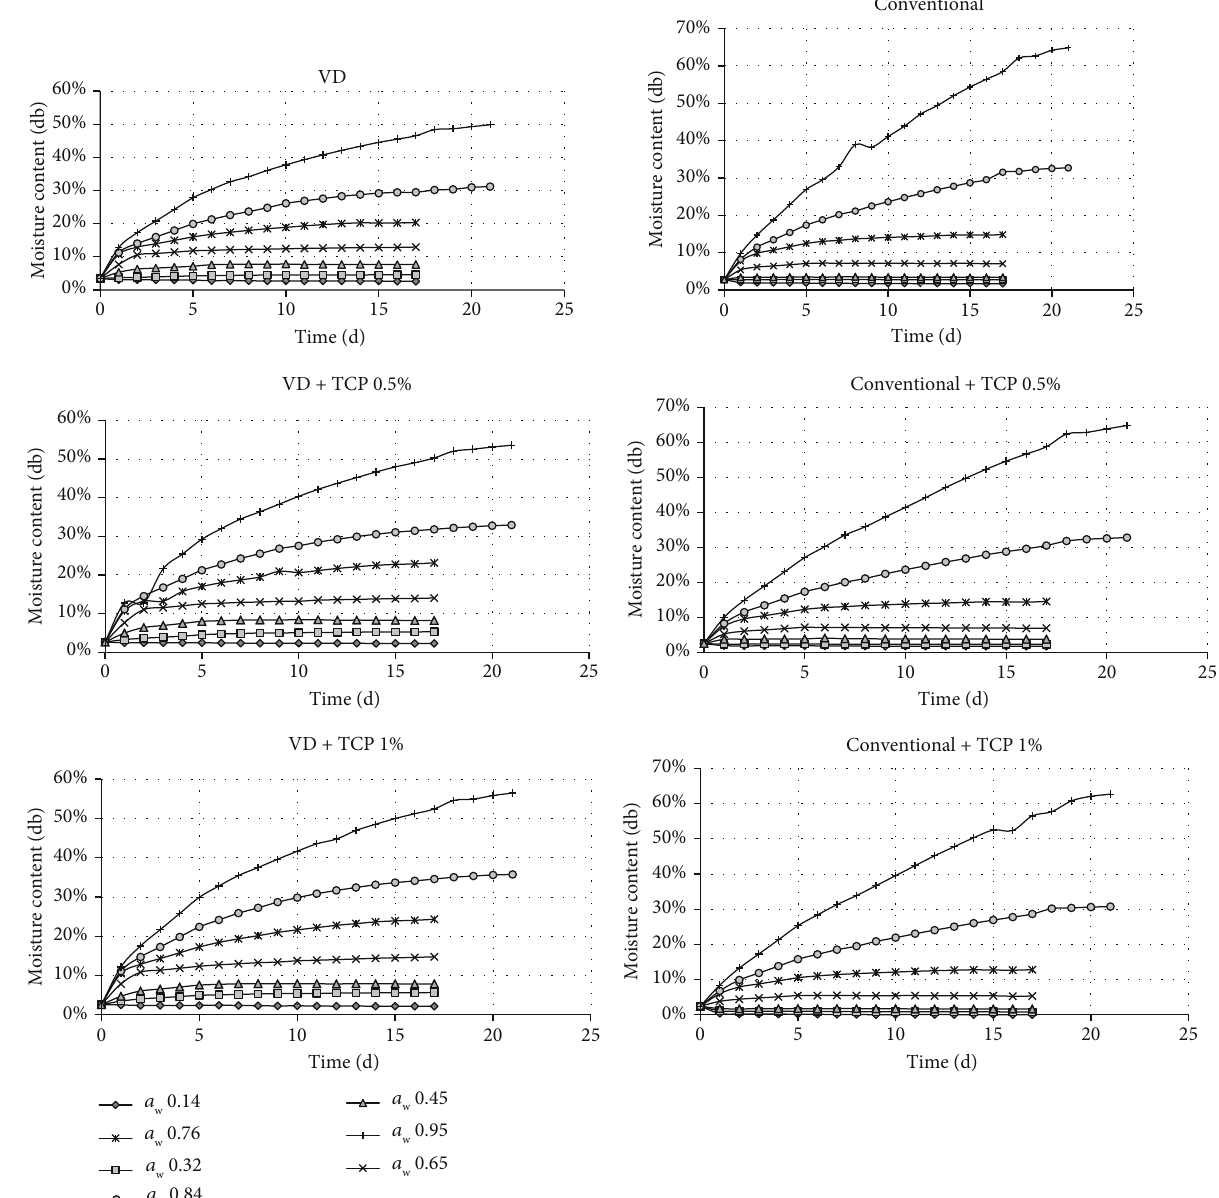
Figure 1: The coconut sugar powder moisture content exposed to di ff erent relative humidities during WSI experiment (db=dry